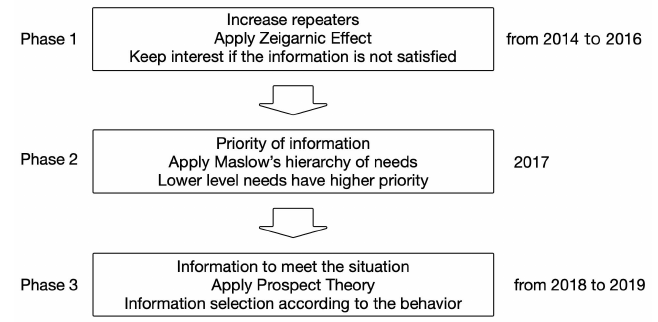
Figure 5. Project